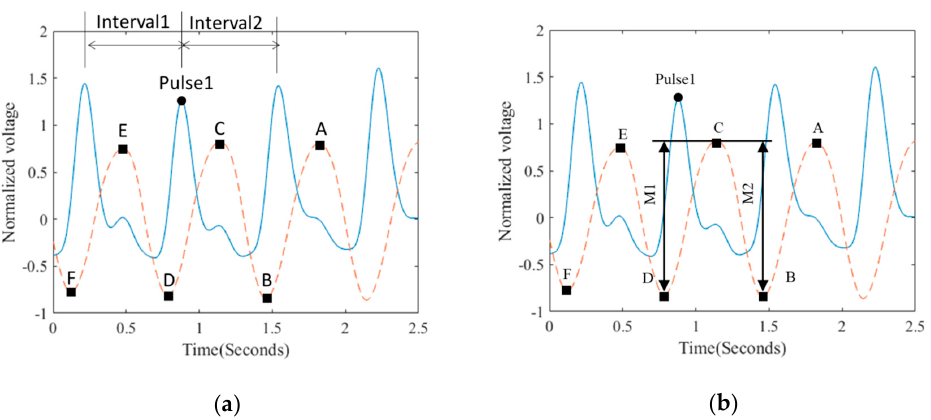
Figure 5. The PPG signal (solid line) and the smoothed PPG signal (dashed line). E, C, and A are the peaks, and E, D, and B are the valleys in the smoothed PPG signal, respectively. ( a ) Schematic explanation for the difference ratio of intervals (dI). ( b ) Schematic explanation for the difference ratio of magnitudes (dM).